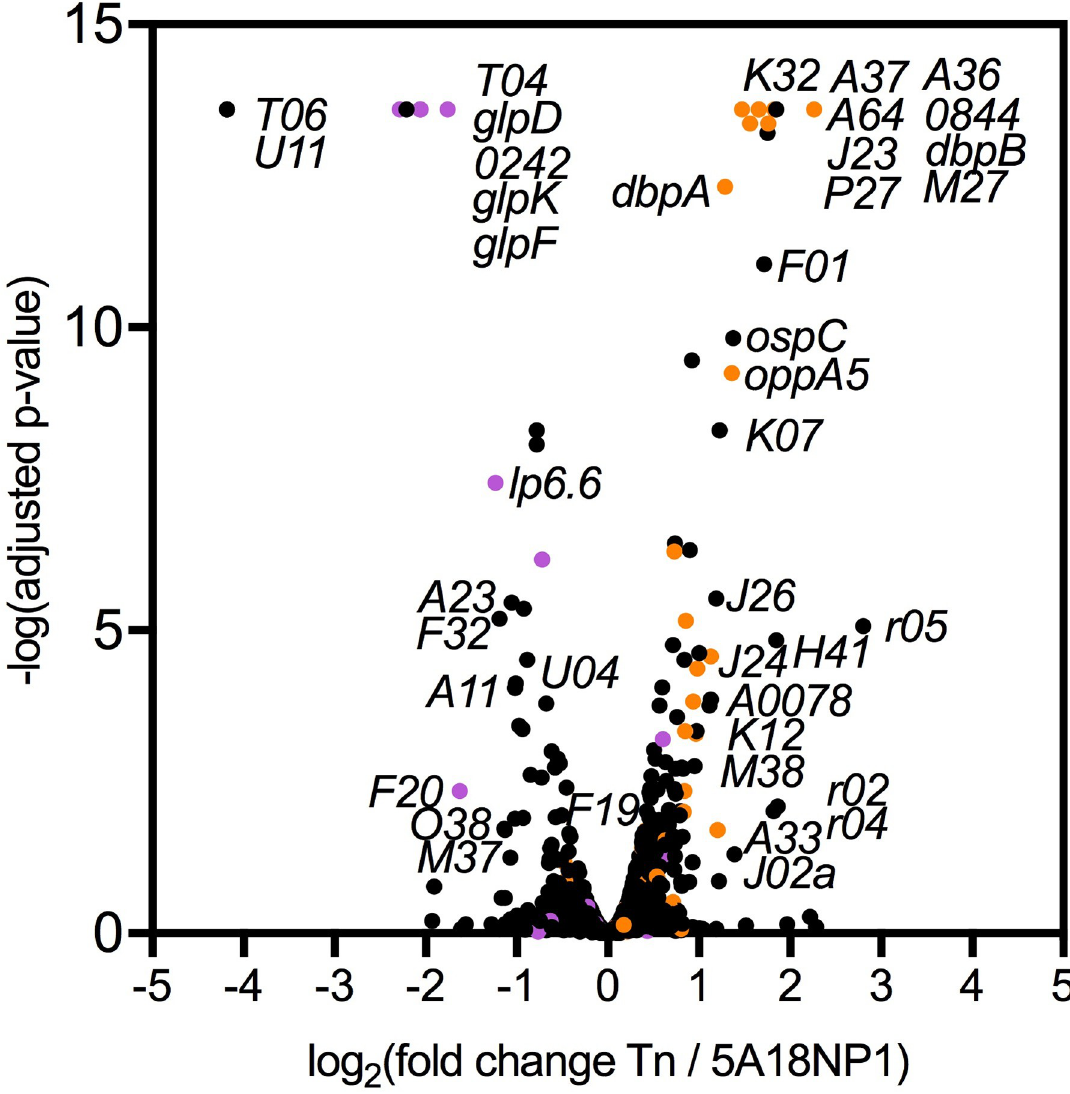
Fig 4. Genes differentially expressed in the Tn:: bb0017 mutant compared to parental strain in RNA-seq experiment. Volcano plot showing differential gene expression between the Tn:: bb0017 mutant and the parental strain. Genes that were significantly different are labeled by name in the graph. Purple circles indicates that the gene is repressed by rpoS while orange circles indicates that a gene is activated by rpoS . The gene abbreviation system assigns a letter based on the plasmid location.